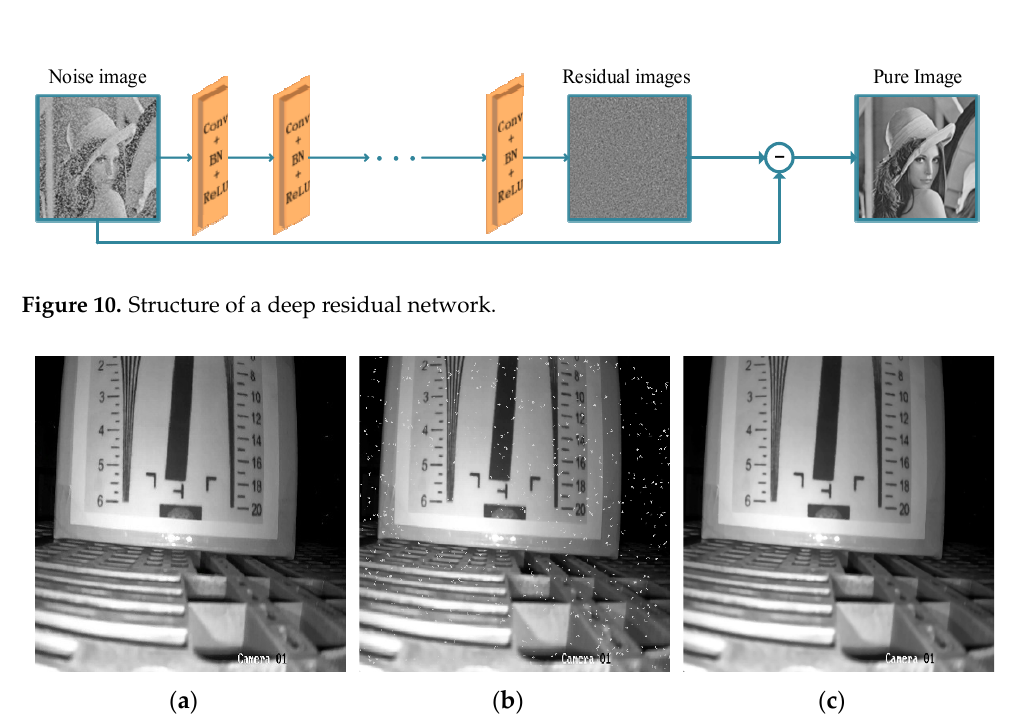
Figure 11. Denoising visualization ( a ) Original image; ( b ) Noise image; and ( c ) Denoised image (Deep Residual Network [8]).